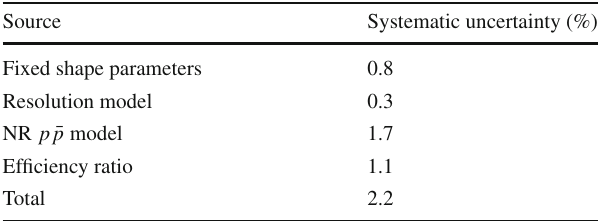
Table 1 Relative systematic uncertainties on the ratio R of Eq. (1). The total systematic uncertainty is obtained from the quadratic sum of